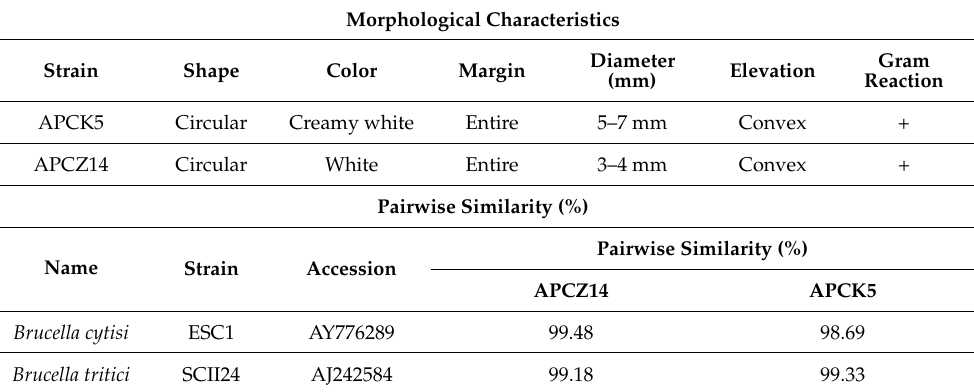
Table 2. Morphological characteristics and pairwise similarity (%) of APCZ14 and APCK5.